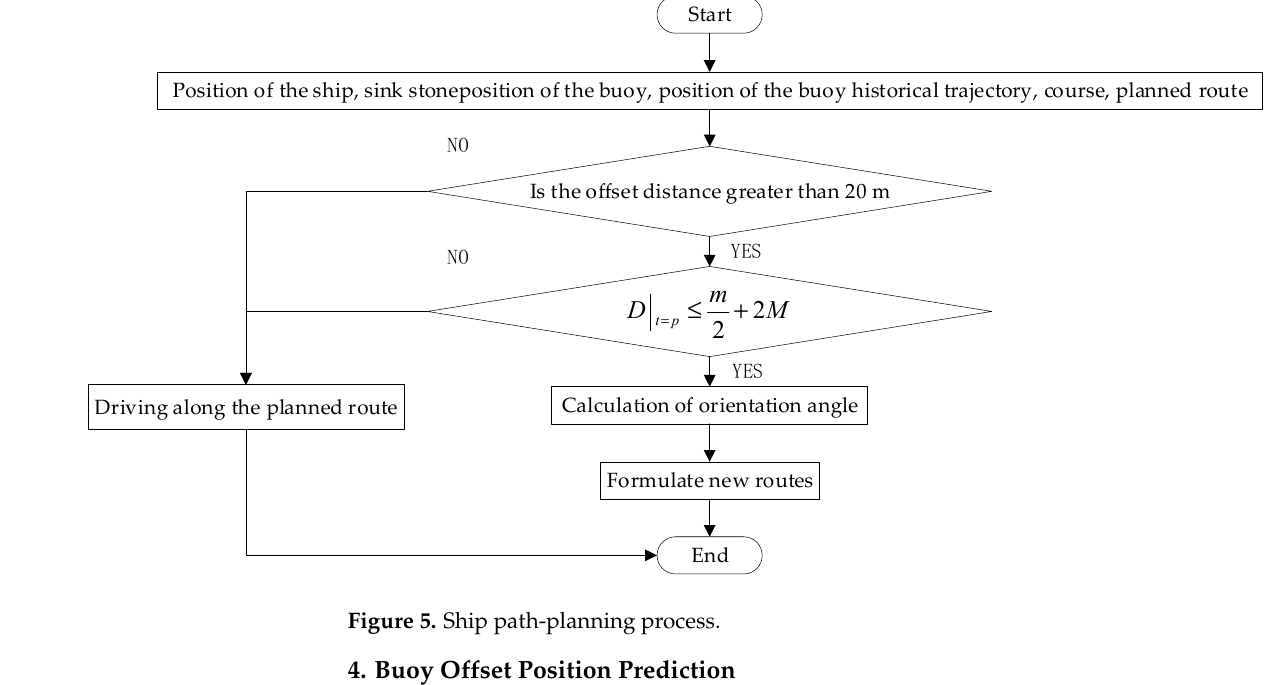
Figure 4. Ships avoid navigation Start Position of the ship, sink stoneposition of the buoy, position of the buoy historical trajectory, course, planned route